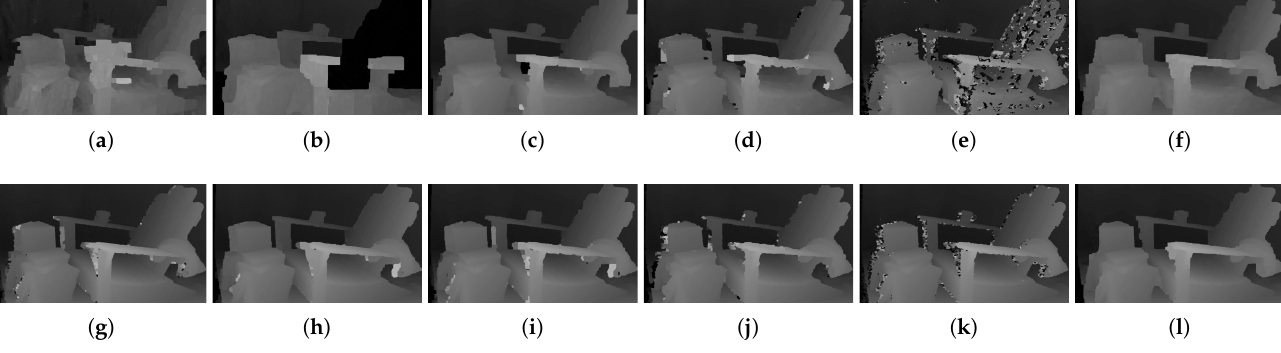
Figure 21. Estimated disparity images of the combinations of cost and image filter using GC stereo method according to low and high parameter of the number of pattern dots . The images in the top row show disparities with the small number of pattern dots , and the images in the bottom row show those with the large number of pattern dots , respectively. ( a ) GC, AD. ( b ) GC, Mean/AD. ( c ) GC, LoG/AD. ( d ) GC, BilSub/AD. ( e ) GC, Rank/AD. ( e ) GC, Census. ( g ) GC, AD. ( h ) GC, Mean/AD. ( i ) GC, LoG/AD. ( j ) GC, BilSub/AD. ( k ) GC, Rank/AD. ( l ) GC,